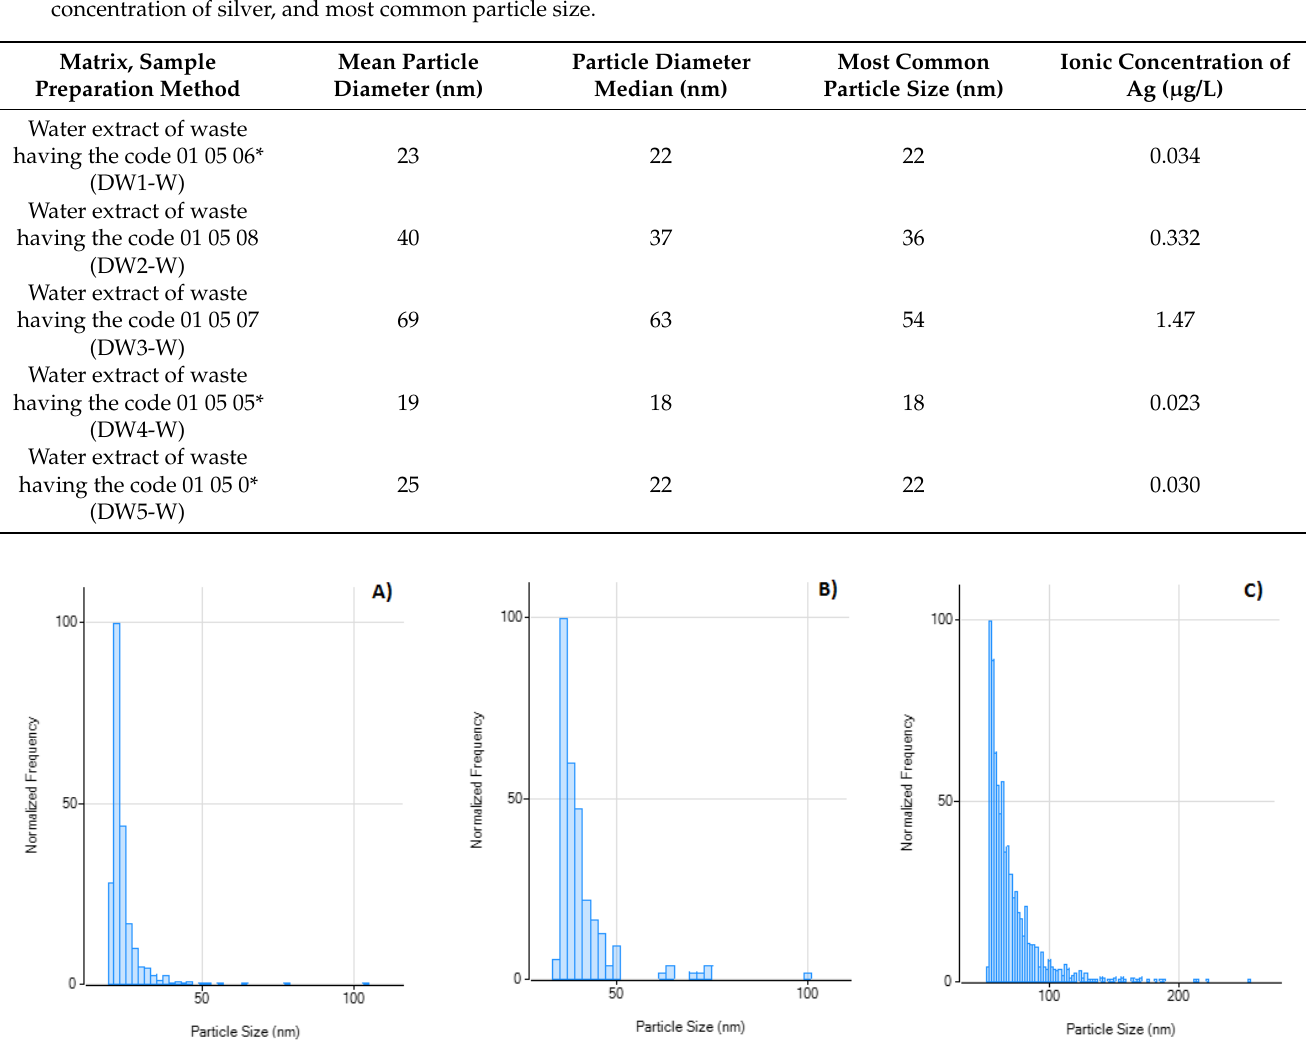
Table 3. Silver particle size measurement results obtained for water extracts of drilling waste described as DW(1-5)-W without AgNP addition. The table contains values obtained for the mean particle diameter, particle diameter median, ionic concentration of silver, and most common particle size.